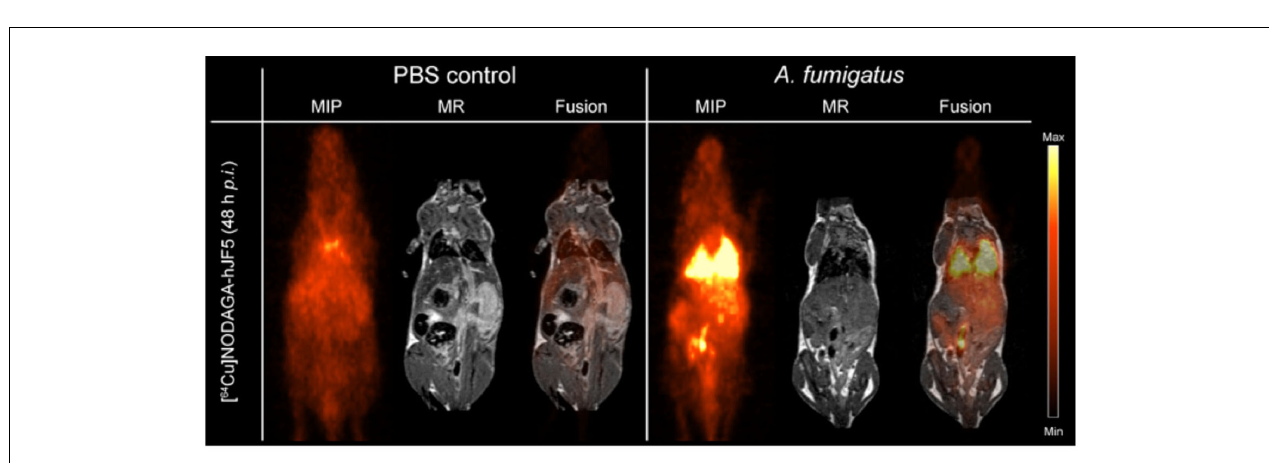
FIGURE 1 | Schematic representation of antibody-guided immunoPET/MR imaging of IPA in a neutropenic mouse model of disease. Twenty-four hours (–1 day) prior to infection with A. fumigatus , and administration of the PET tracer, neutropenia is induced in mice by the injection of 100 µ g of the anti-Ly-6G/anti-Ly6C antibody RB6-8C5. At time 0, mice are infected by intratracheal injection with an A. fumigatus spore suspension and with simultaneous tail vein injection with a JF5-based PET tracer. The tracer shown is mAb JF5 conjugated to the positron emitter 64 Cu using the chelator NODAGA. Simultaneous PET/MR imaging of animals is then performed 3, 24, and 48 h after infection/tracer injection. Ex vivo bio-distribution and autoradiography are conducted after the last PET scan at 48 h. Adapted from Davies et al. (2017).